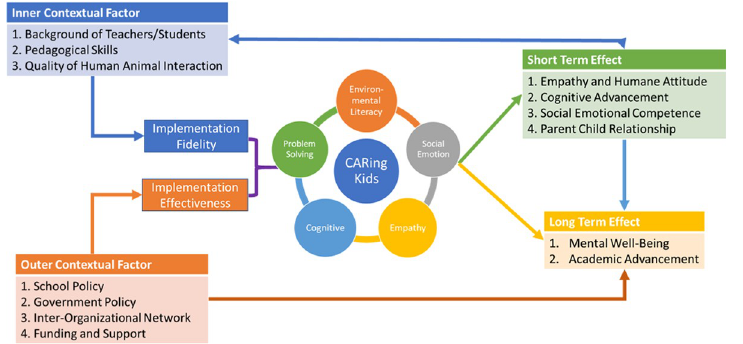
Fig 2. The CARing Kids conceptual